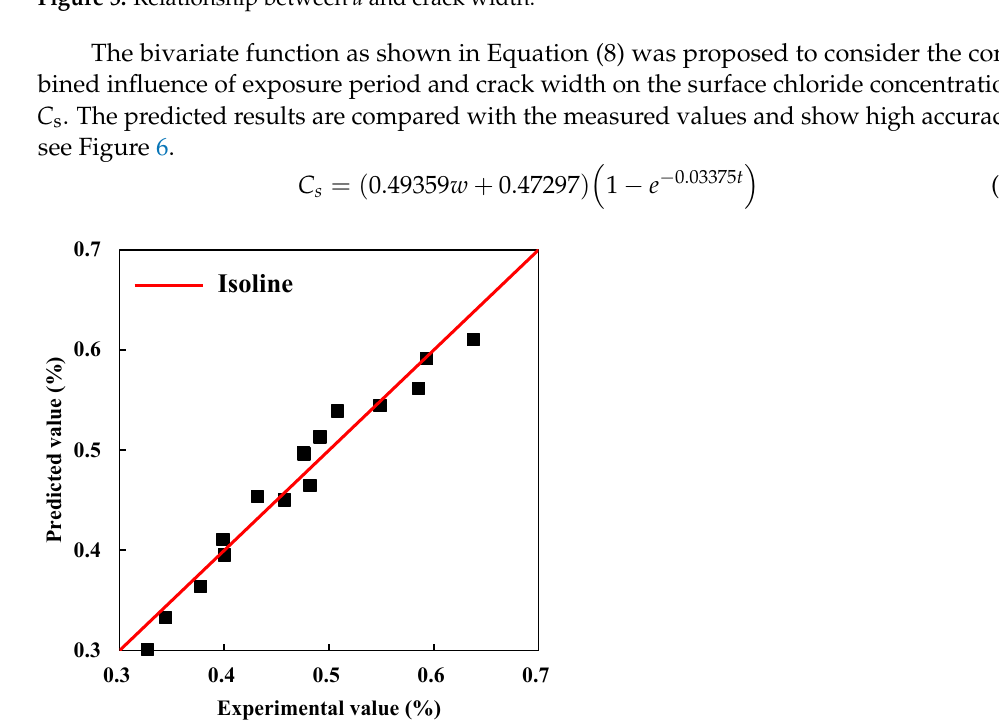
Figure 5. Relationship between a and crack width.